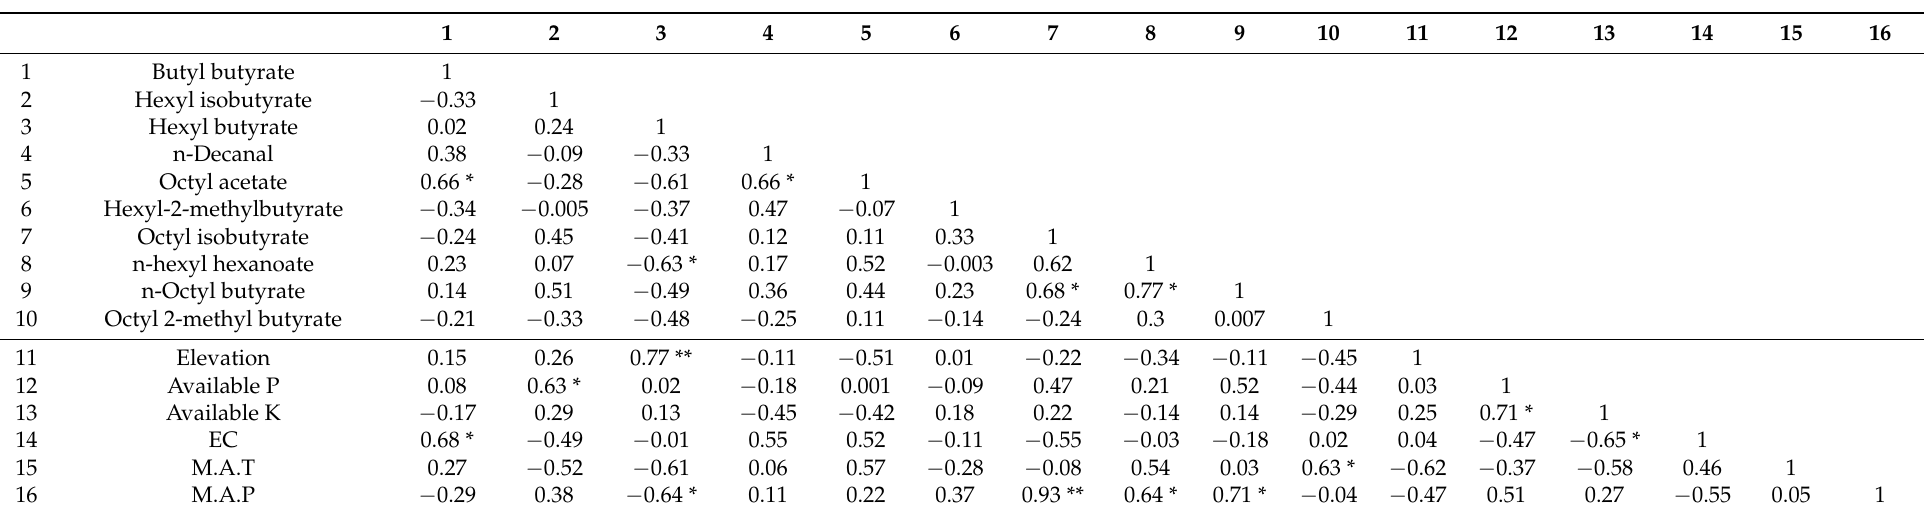
Table 4. Correlation of major components of Heracleum persicum and environmental